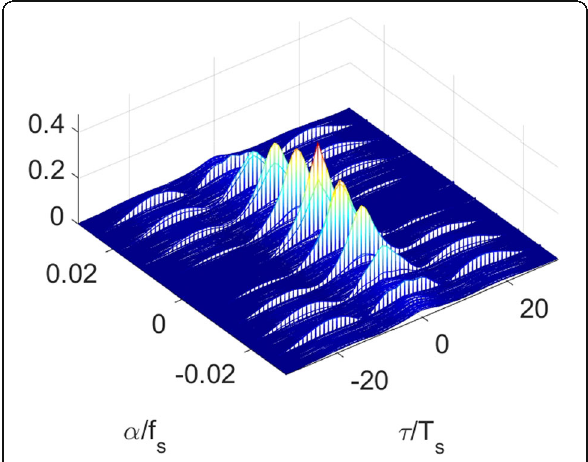
Fig. 3 Case A: magnitude of the cyclic correlogram of the un-warped data, with SNR ¼ 10 dB, as a function of normalized cycle frequency and lag, α / f s and τ / T s ð f s ¼ 1 = T s